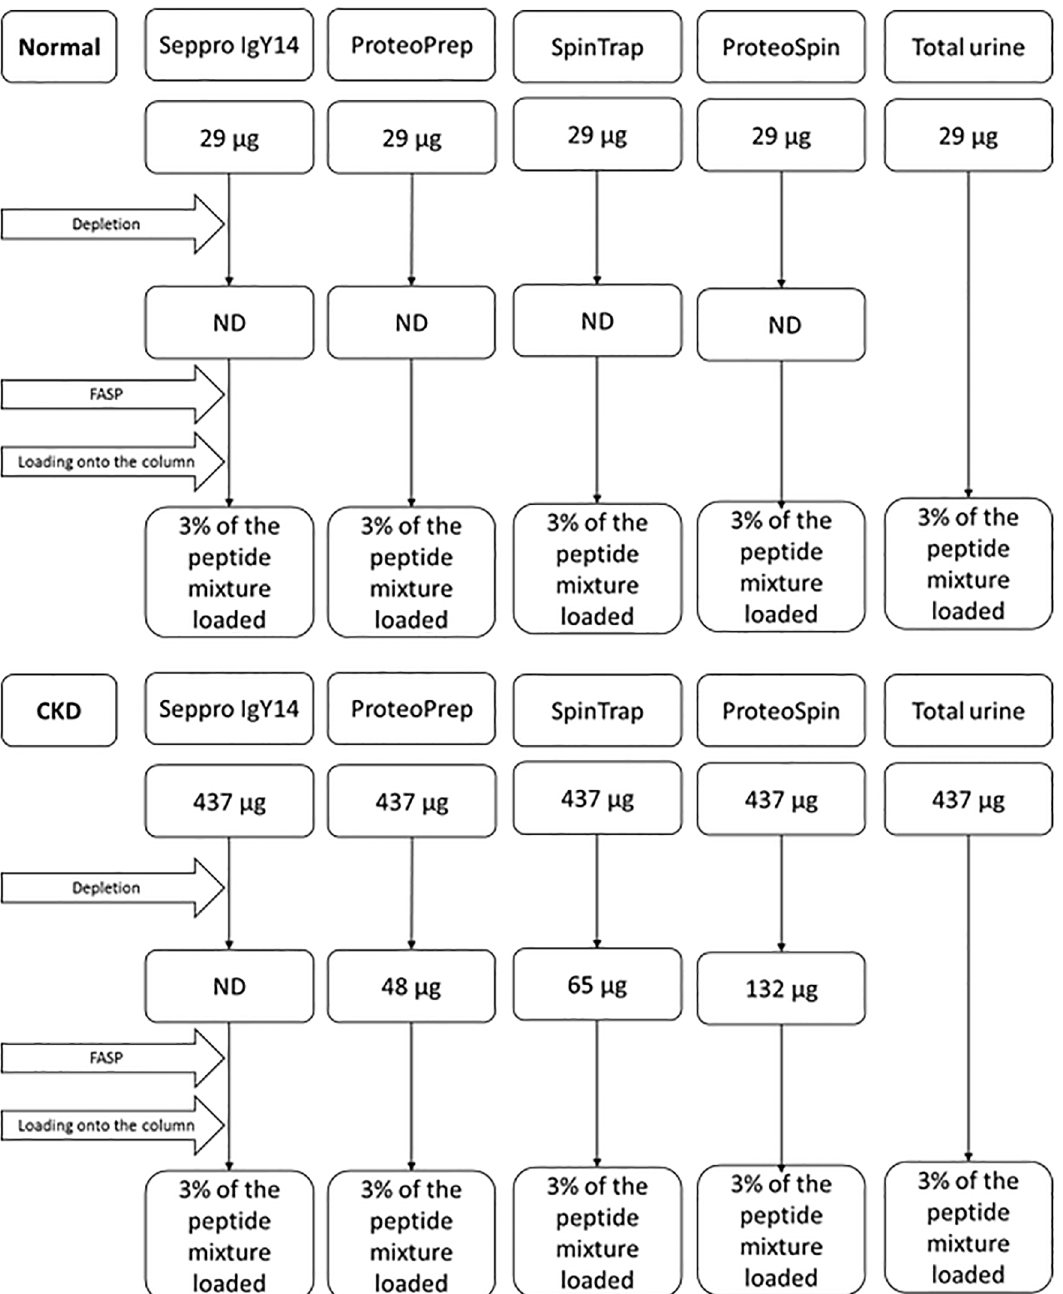
Fig 1. Protein amounts at different steps of the analysis as estimated by Bradford measurements. ND: not determined due to measurements being below the limit of detection (i.e. concentration < 0.2 μ g/ μ L).